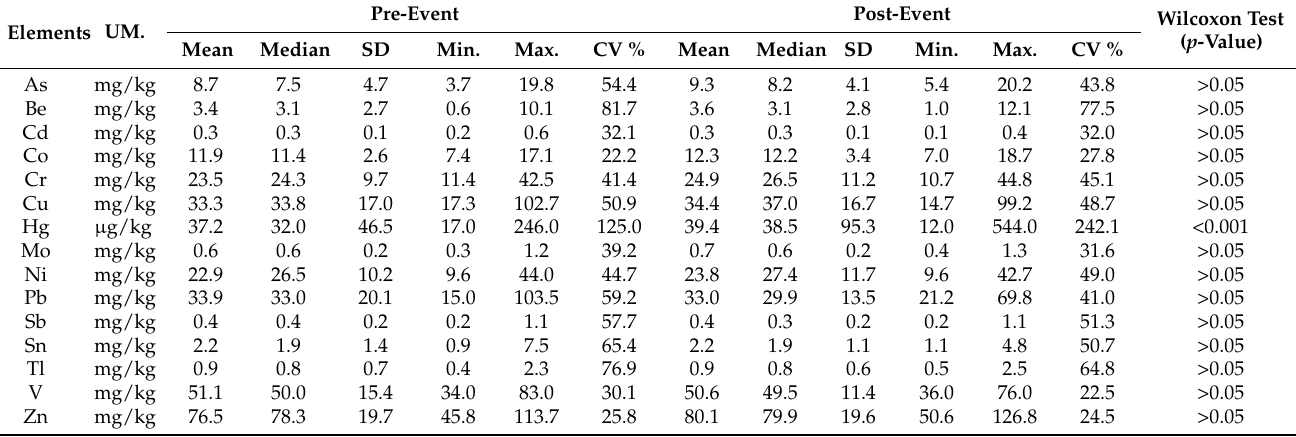
Table 1. Ilside site. Descriptive statistics of the PTEs in the soil before and after the fire event. p -value ranges: p > 0.05 not significant; p < 0.05 significant; p < 0.01 very significant; and p < 0.001 highly